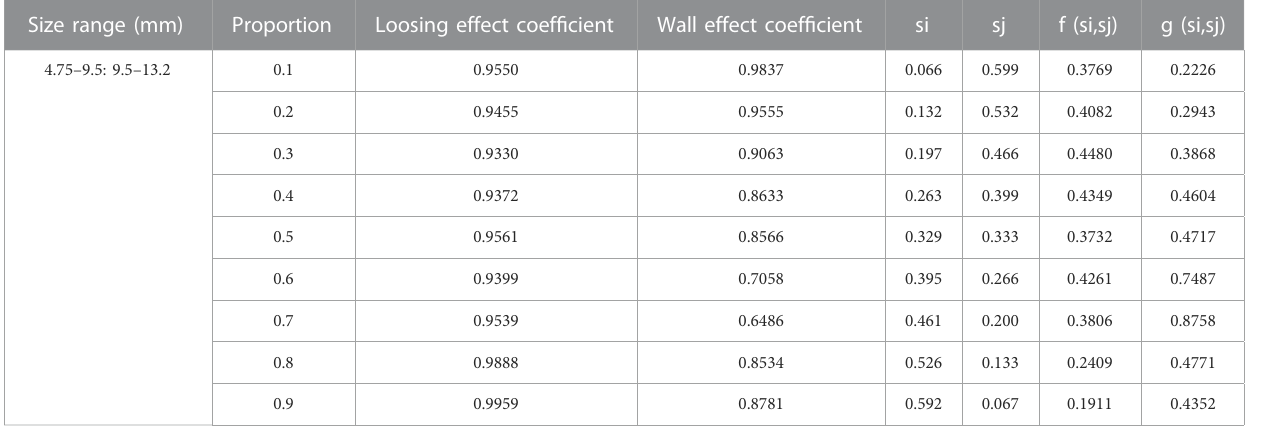
TABLE 2 Morphology values of the binary accumulations. Size range (mm)